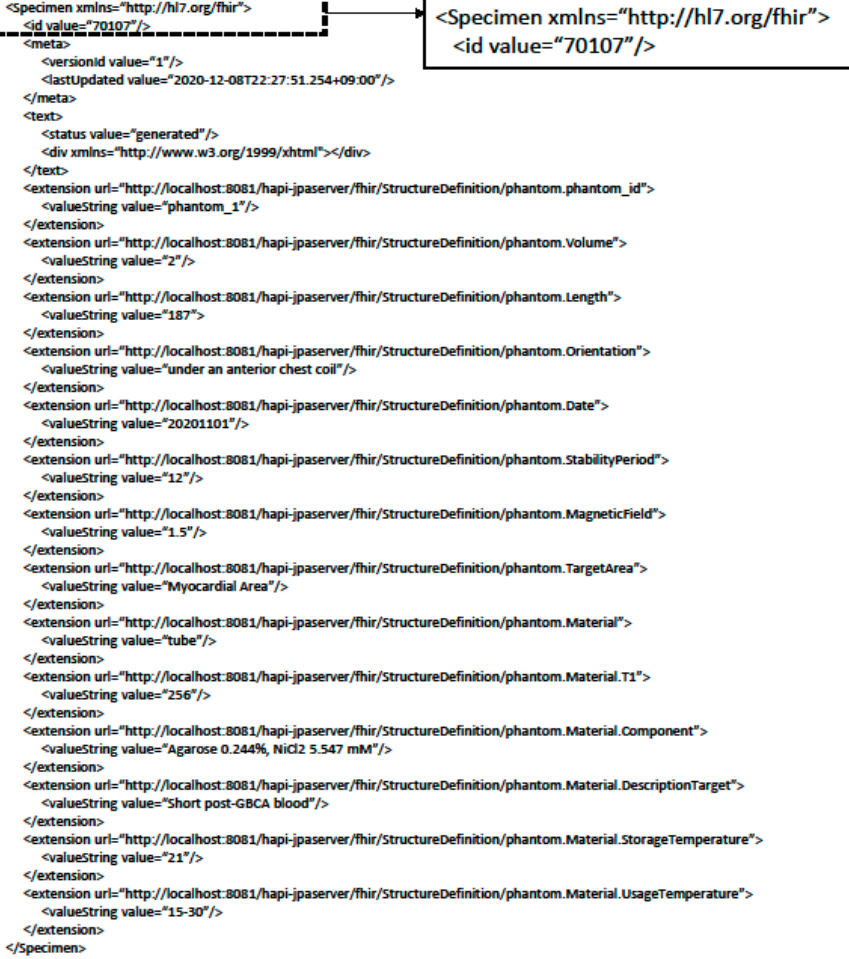
Figure 9. Example of Specimen Resource XML Transmission Results using Phantom Resource.